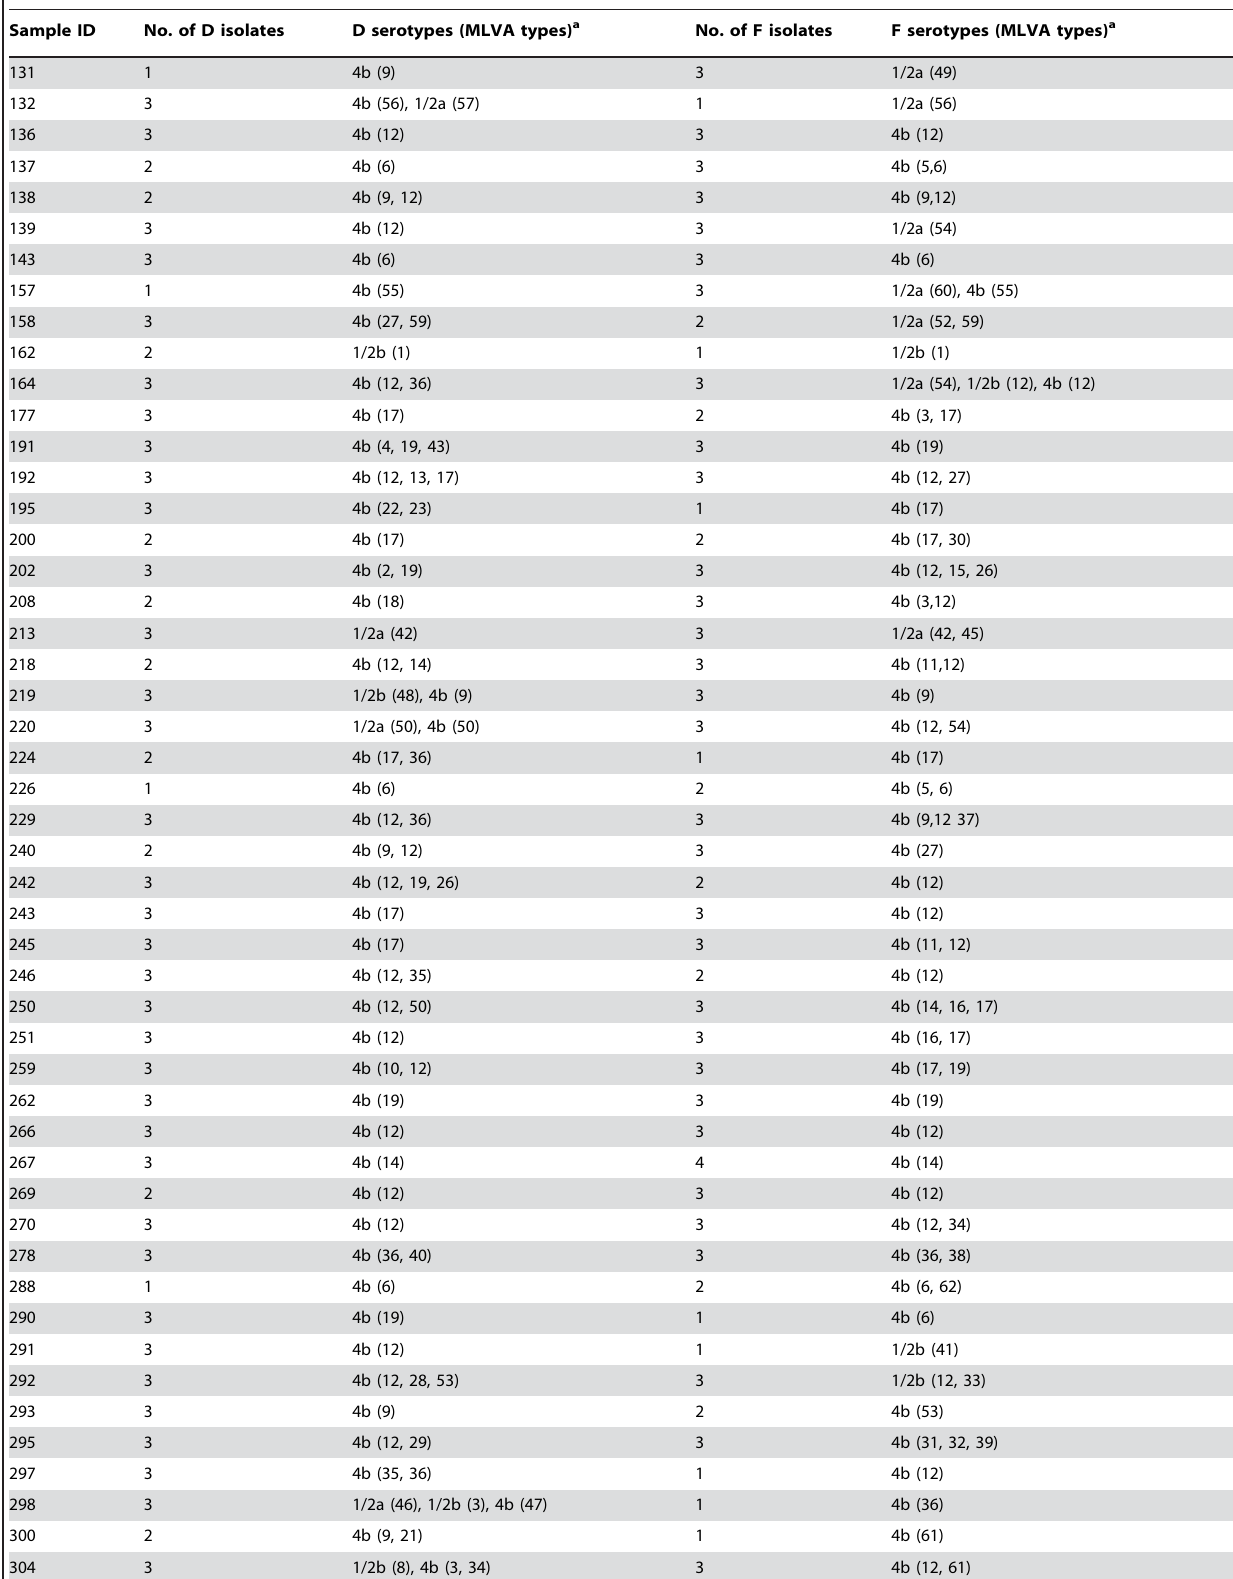
Table 3. Characterization of isolates from